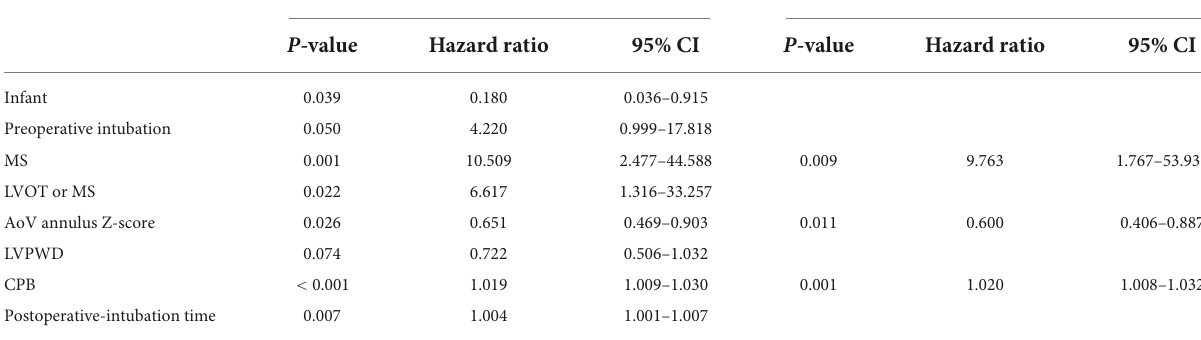
TABLE 3 Univariate and multivariate analyses for overall